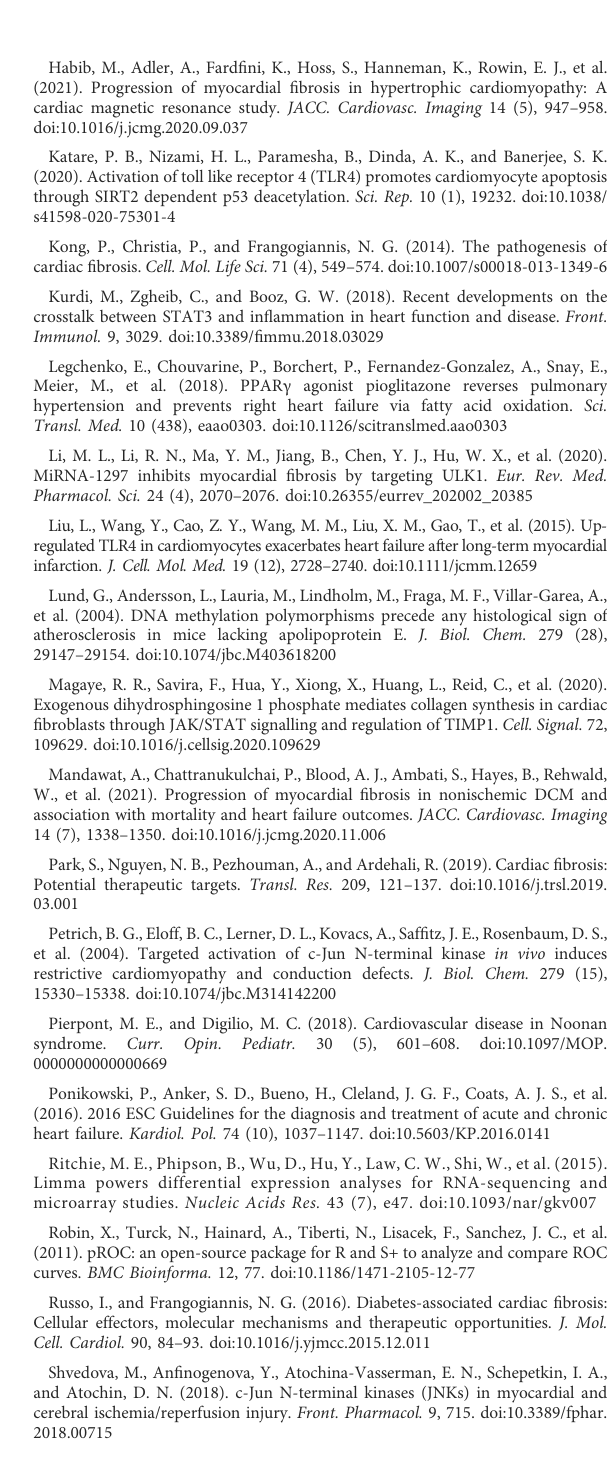
SUPPLEMENTARY TABLE S4 The fi brosis-related DEGs were enriched into 1651 BPs, 88 CCs and 72 MFs.